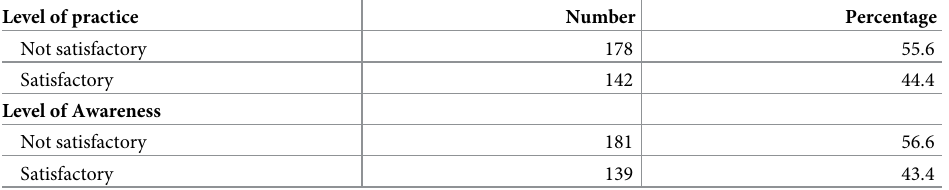
Table 3. Distribution of participants by their level of awareness and practice on meat hygiene. Level of